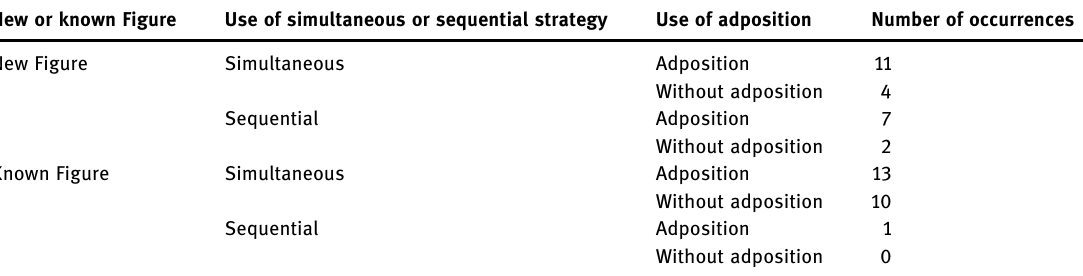
Table 4: A summary of strategies used in expressing spatial relationships between Figure and Ground New or known